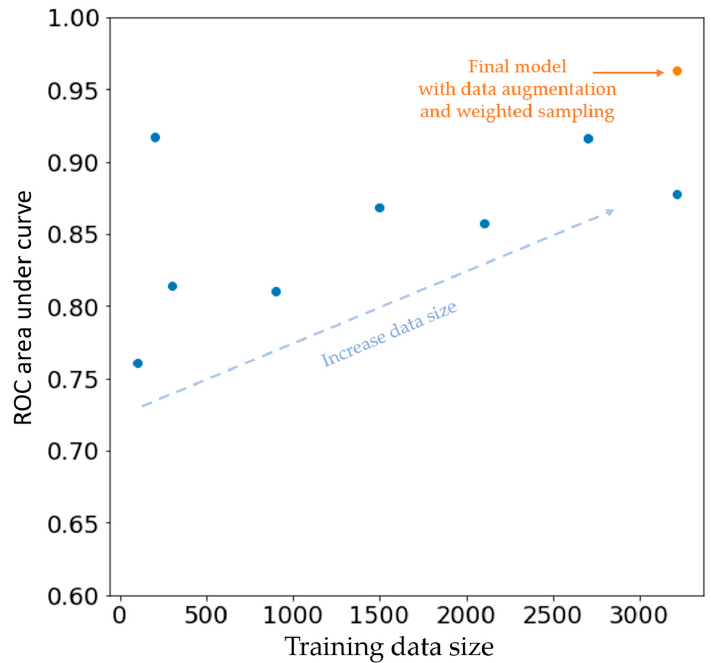
Figure 5. Change in model performance with the increasing size of training data. Each blue dot indicates model performance with a different training data size. The orange dot indicates the final model with the implementation of weighted sampling and data augmentation. The vertical axis is the area under the curve of the ROC from a different model and the horizontal axis is the data size being used. The unit of the data set shown here is one single VPC wave.